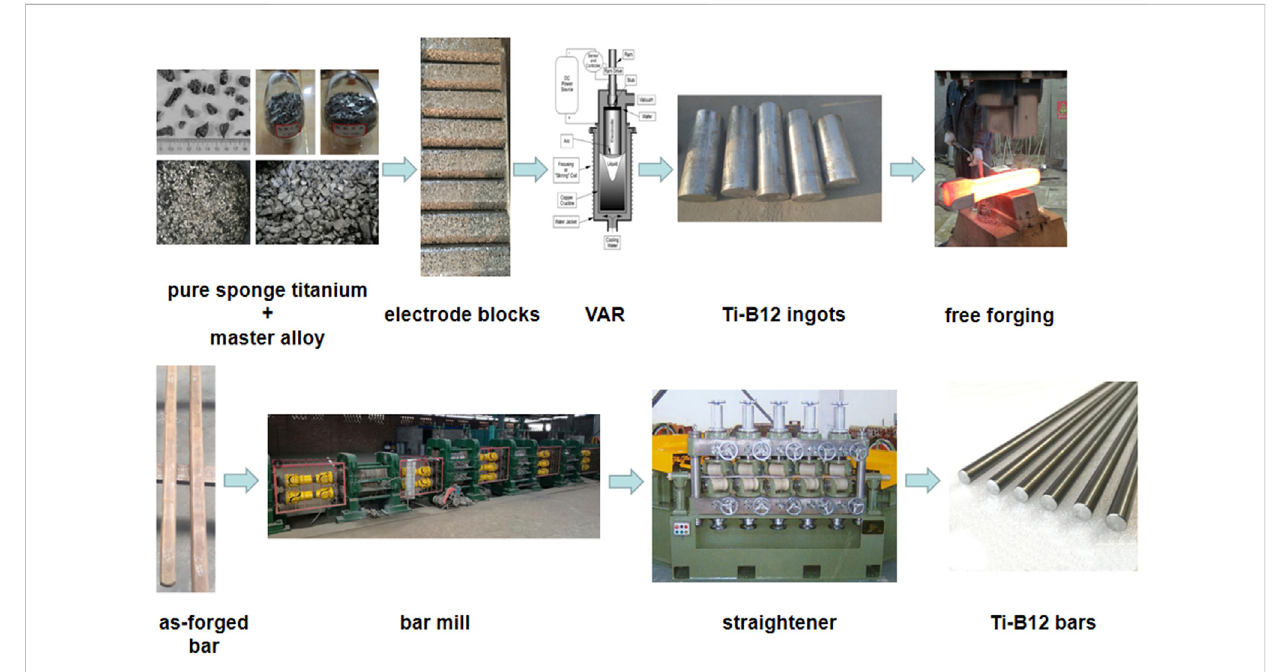
FIGURE 1 Synthesis process of Ti-B12 titanium